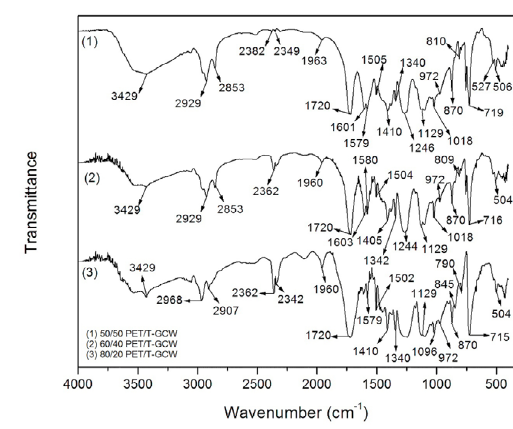
Figure 4. Overlay of the FT-IR spectra for the PET/T-GCW composites.